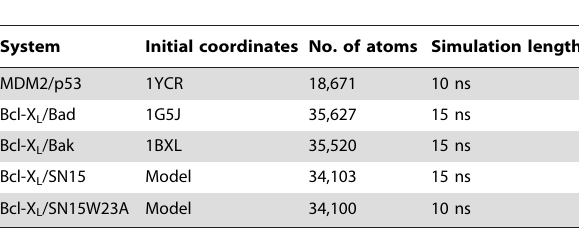
Table 1. Summary of MD simulations performed in present